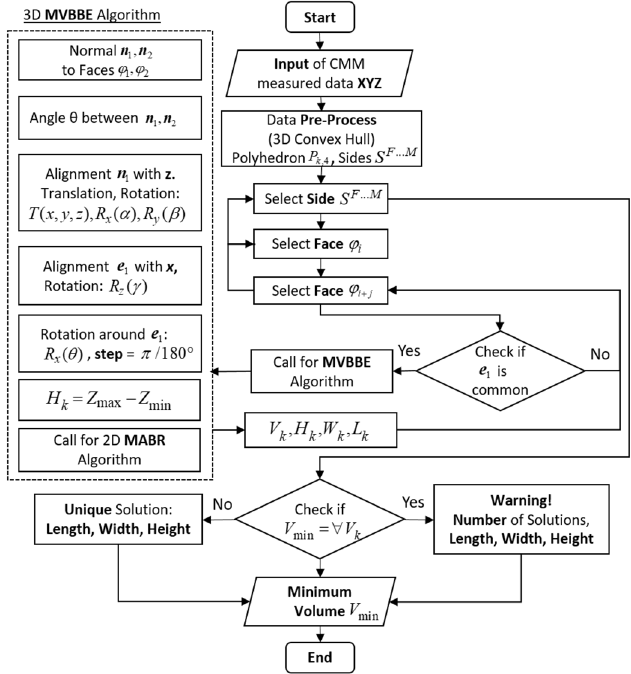
Fig. 9. The fl owchart of the MVBBE method.